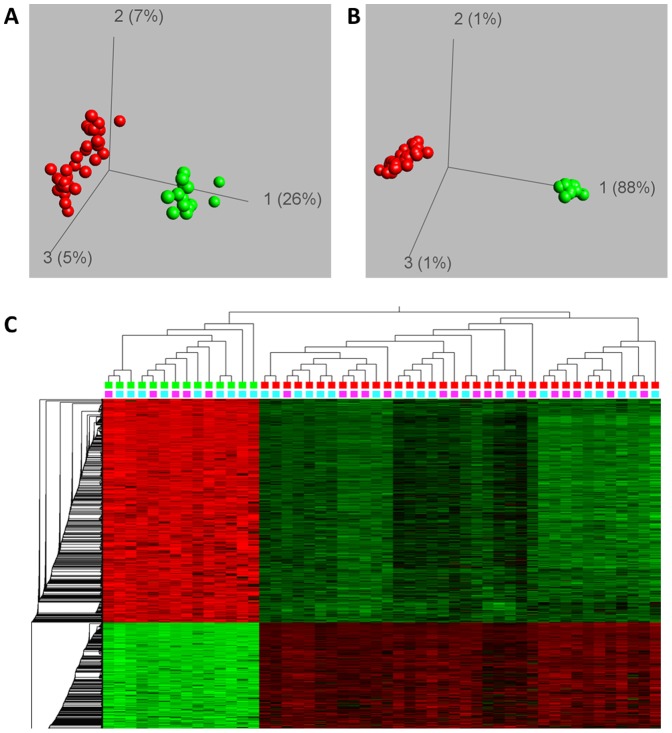
DNA methylation differs between AC and CVS samples.(A) Principal component analysis (PCA) of 22,234 CpG loci which passed quality tests and entered the analysis. Unsupervised analysis separated AC (green spheres) from CVS samples (red spheres). (B) Differential methylation analysis to separate AC from CVS samples (t-test, FDR<1×10−15). (C) Hierarchic cluster analysis of the 2418 CpG loci shown in (B). The upper panel on top of the heatmap indicates the sample type (green: AC, red:CVS) while the second panel indicates the fetuses’ sex (pink: female, cyan: male). Green color in the heatmap indicates low DNA-methylation, black intermediate and red high DNA-methylation values. Samples with known chromosomal aberrations and samples from ICSI were excluded. AC and CVS differ significantly in their DNA methylation pattern.